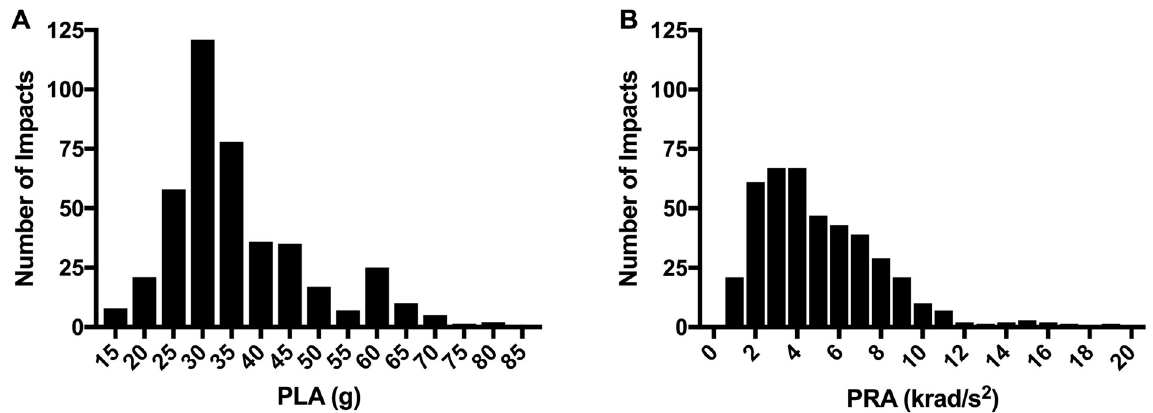
Fig 3. Frequency distribution of head impacts by magnitude of A, peak linear acceleration (PLA), and B, peak rotational acceleration (PRA).